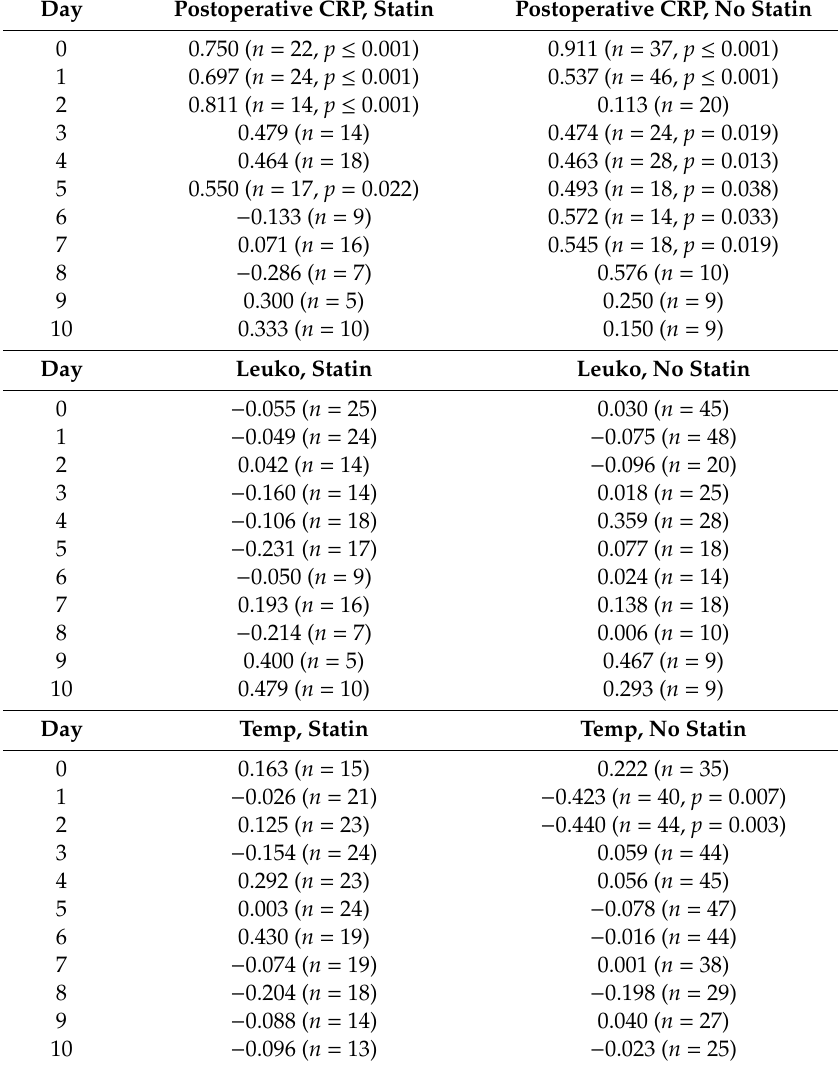
Table 7. Subgroup correlation analysis, female patients regarding statin